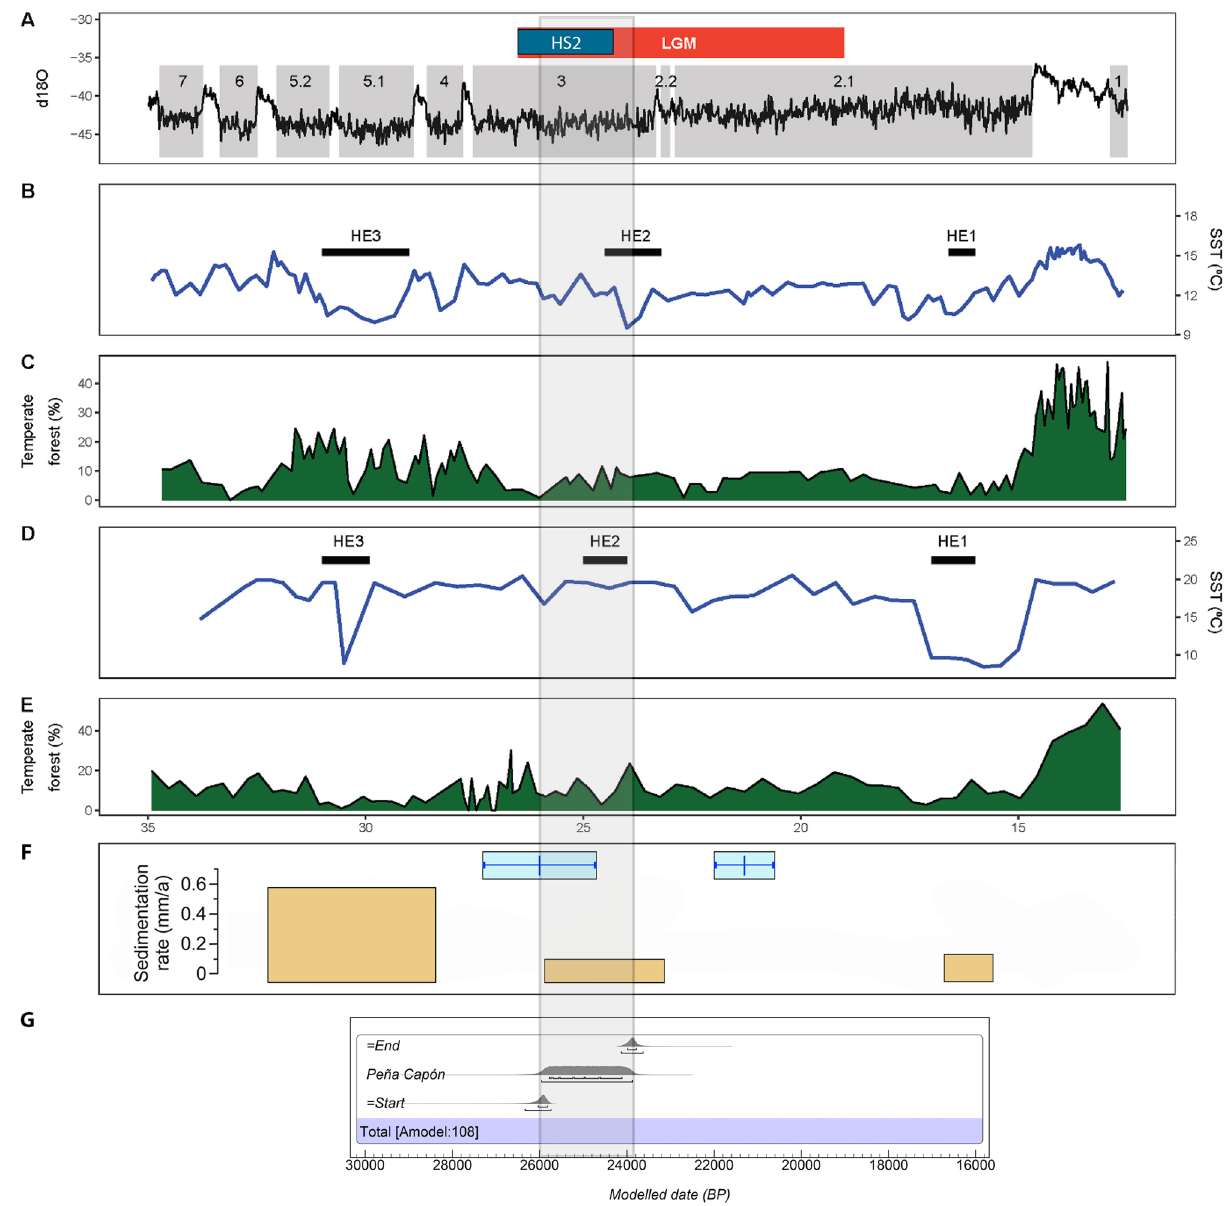
Figure 11. Global and regional Iberian climatic/environmental proxies from ∼ 35 to 12.5 ka cal BP (modified from [ 43 : fig. 1] and [ 40 : fig. 3] in relation to the modeled sequence of human occupation recorded at Peña Capón. A: δ18O record of the NGRIP ice core, with numbers and grey bars referring to Greenland Stadials 67 , and indication of the LGM and HS2 chronology 68,69 . B: Sea Surface Temperature reconstructions of marine drilling core MD95-2043 (Alborán Sea) 99 , and Heinrich Events detected in the same core. C: Percentage of temperate forest pollen in core MD95-2043 100 . D: Sea Surface Temperature reconstructions of marine cores MD95-2042 and SU81-18 (Atlantic) 101 and Heinrich Events detected in the same cores. E: Percentage of temperate forest pollen in cores MD95-2042 and SU81-18. F: Main loess deposition periods and their sedimentation rates recorded in the Upper Tagus Basin (ochre bars) 40 and Maximum extension stages of glaciers recorded in the Iberian Central System Range (blue bars) 102 . G: Estimated duration of the human occupation recorded at Peña Capón, based on the Bayesian Model 2 (Fig. 6) as calculated by the ‘date’ command in OSL date as old as 33.6 ± 2.0 ka cal BP associated to Aurignacian assemblages 14 (Fig. 1B,C). Although these dates shorten the gap of human occupation after the Neandertal disappearance for the western margins of the plateau, in the rest of the Iberian hinterland, and especially in the very center, there is still a hiatus of ∼ 16,000 years devoid of human populations between ∼ 42 and 26 ka cal BP 40,110,111 .